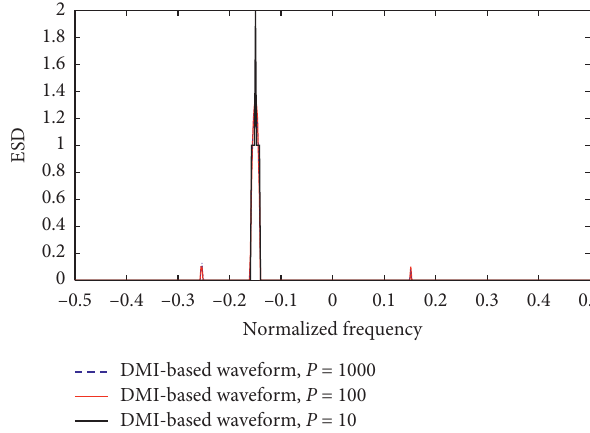
Figure 6: DMI-based waveforms with different P values.